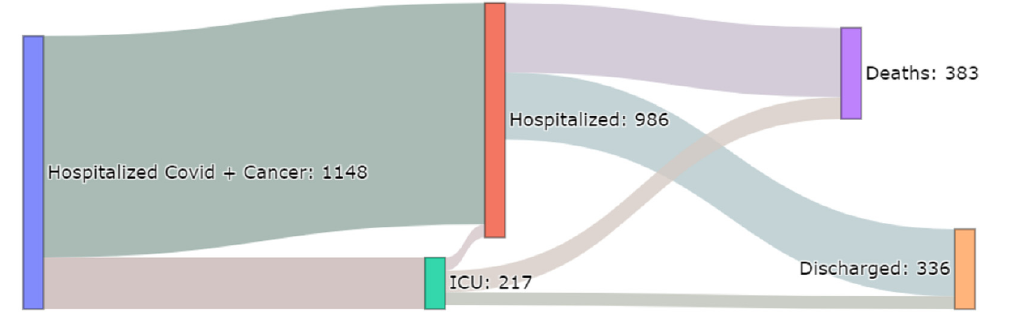
Figure 3. Flow of trajectories of hospitalized cancer patients diagnosed for COVID-19 at AP-HP up to 20 May 2020.